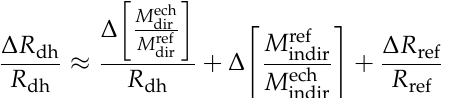
Figure A11. The Labsphere Infragold sample used at